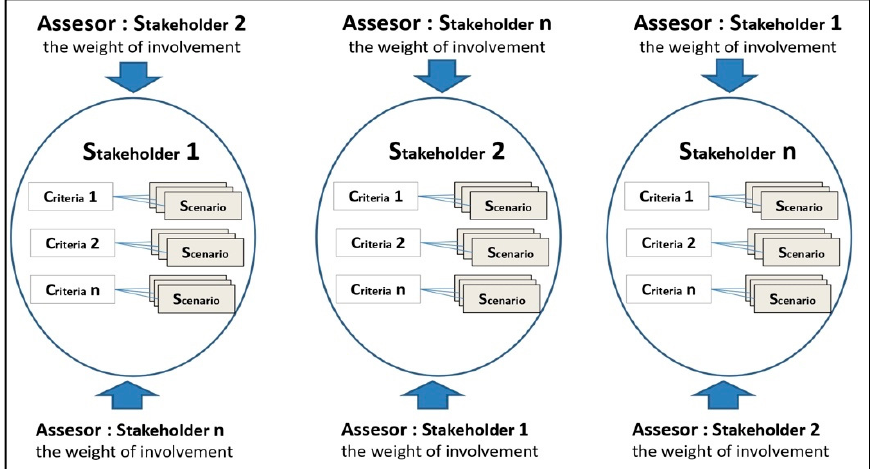
Figure 3. Weight of stakeholder involvement in a transportation policy